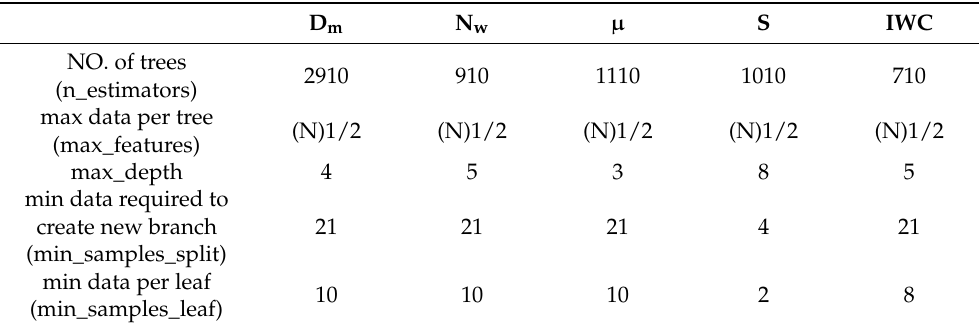
Table 3. The most optimal parameters used to generate the RF model to predict D m , N w , µ , S, and IWC. D m N